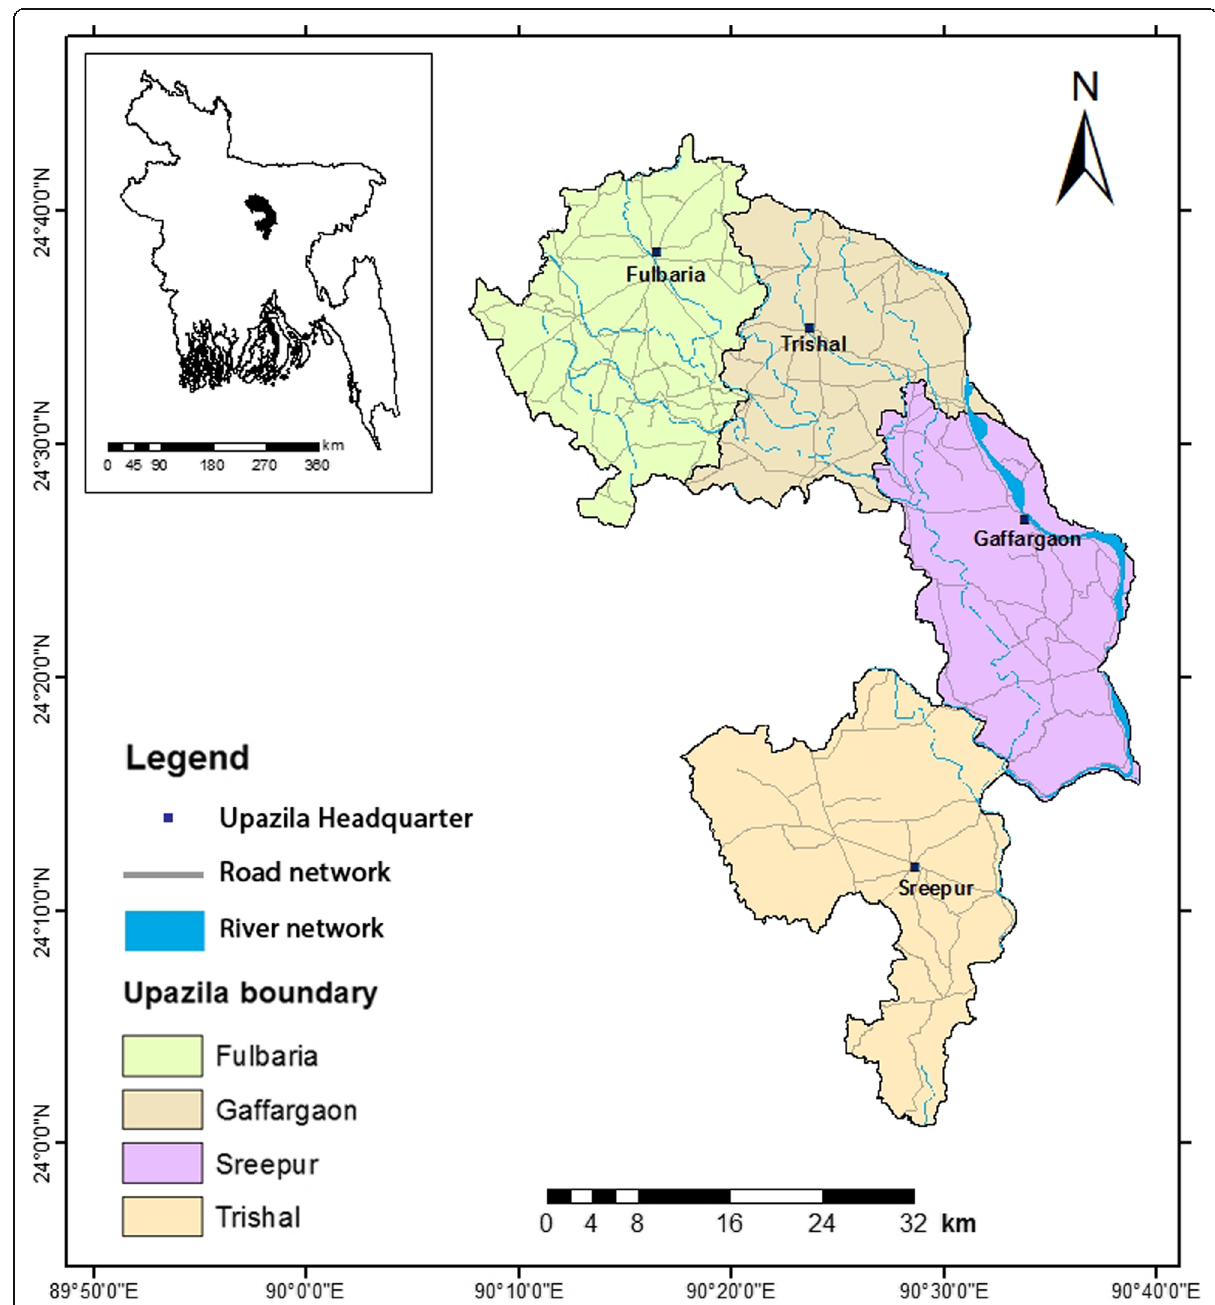
Fig. 1 Location of the study area, showing four upazilas in the Mymensingh and Gazipur districts. The inset map shows the location of the study area with respect to